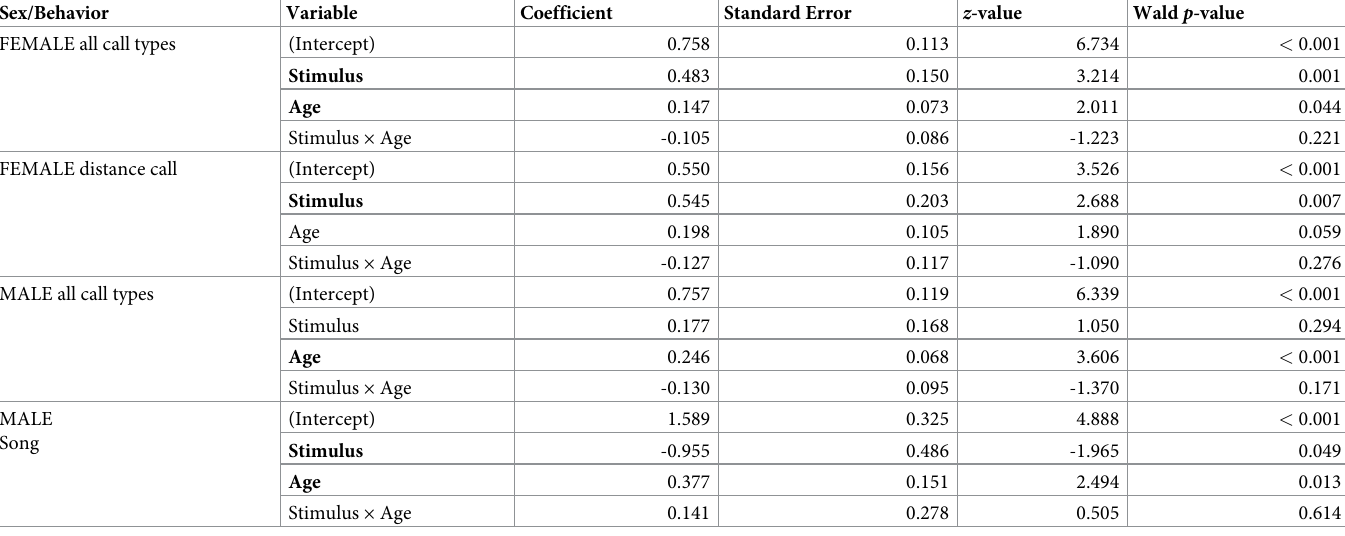
Table 4. Results of the estimation of models (GLMMs) fitted to vocal response